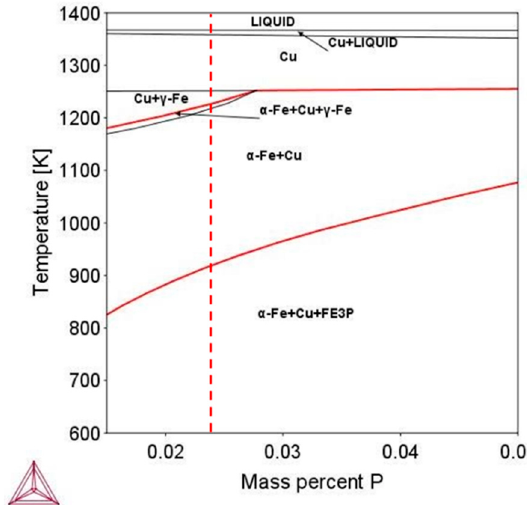
Figure 4. Isopleth section of CuFe 2 P alloy phase diagram—P dependency. The red lines show the temperatures at which α -Fe and Fe 3 P particles are formed depending on P content.